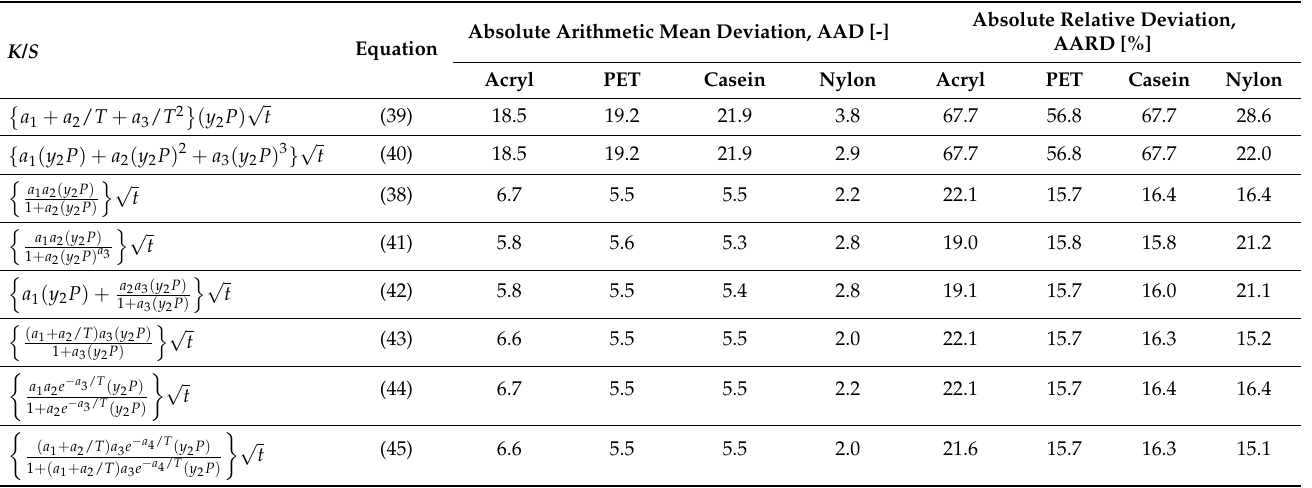
Table 7. Absolute arithmetic mean deviation and relative mean deviation for K / S between experi- mental and calculated values obtained by Equations (38) to